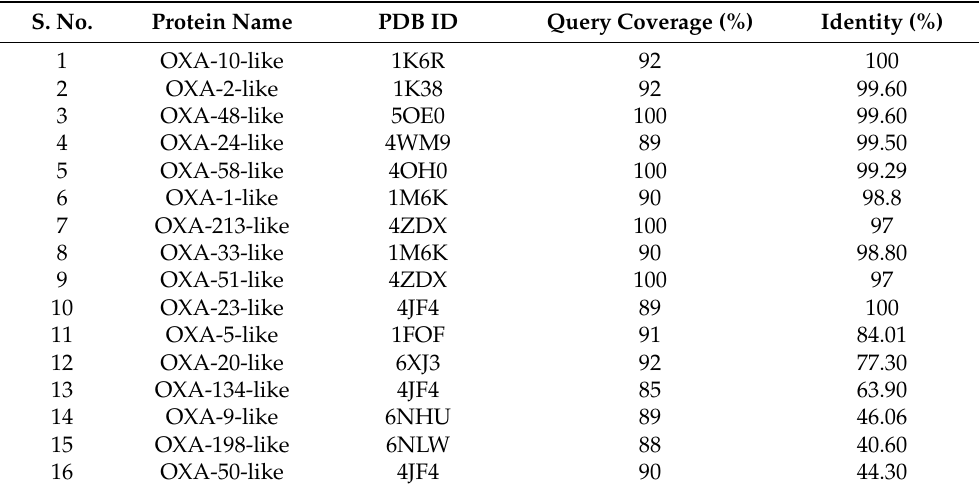
Table 5. PDB IDs of the structural representatives of the 16 OXA subfamilies with query coverage and identity